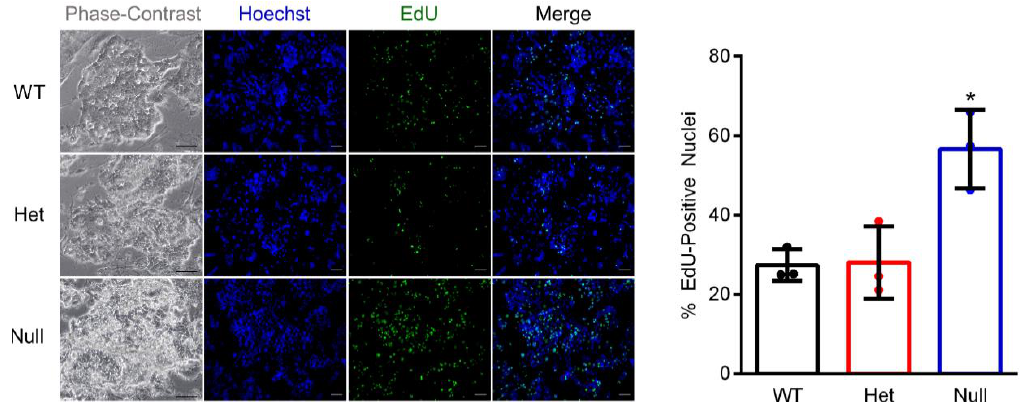
Figure 5. Ovol2 -null TS cells exhibit increased proliferation. Representative phase-contrast images (left panels) of wild-type (WT), Ovol2 -heterozygote (Het), and Ovol2 -null mouse TS cells. Detection of incorporated EdU (green) was used to assess proliferation of cells. Hoechst was used to detect nuclei (blue). The percent EdU-positive nuclei is shown in the graph on the right. Values significantly different from WT (N = 3, P < 0.05) are indicated with an asterisk (*). Scale bars = 100 µm. Graph represents means (SD).